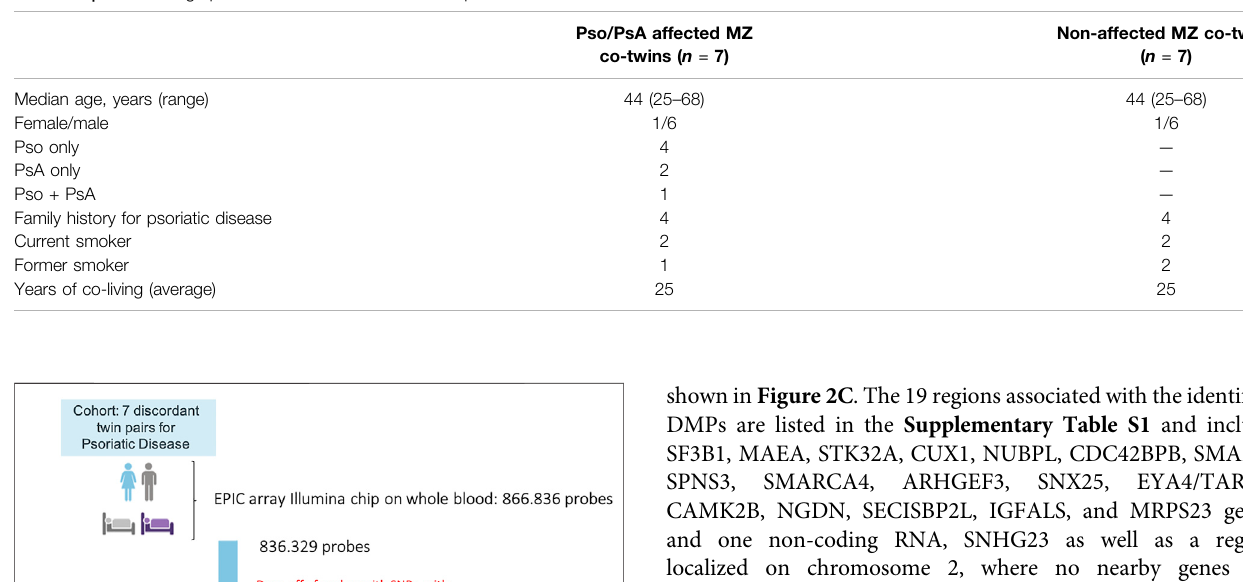
TABLE 1 | Main demographic and clinical features of the 7 pairs of MZ twins discordant for Pso or PsA.